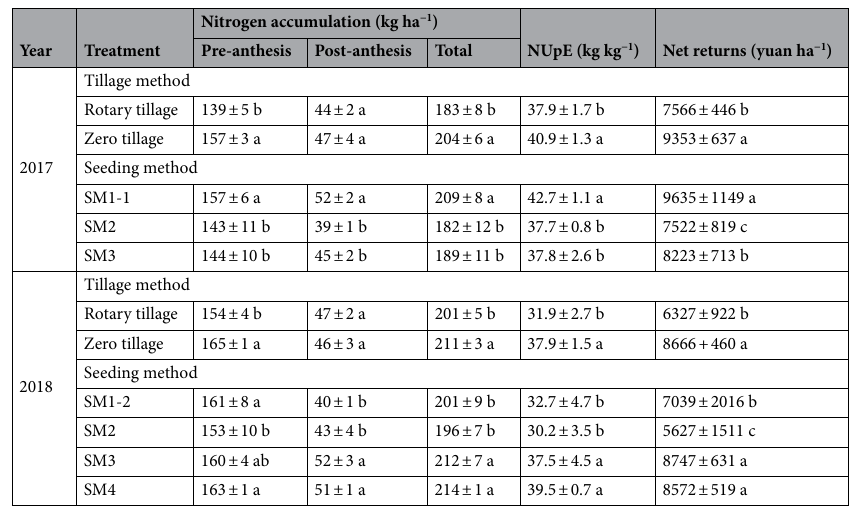
Table 6. The effects of the tillage method and seeding method on nitrogen accumulation, nitrogen uptake efficiency (NUpE), and the net returns in 2017 and 2018. Data are presented as means ± standard error. Different letters indicate significant differences between treatments at the 0.05 probability level. SM1-1 small- size broadcast seeder, SM1-2 small-size drill seeder, SM2 small-size strip seeder, SM3 medium-size strip seeder, SM4 medium-size drill